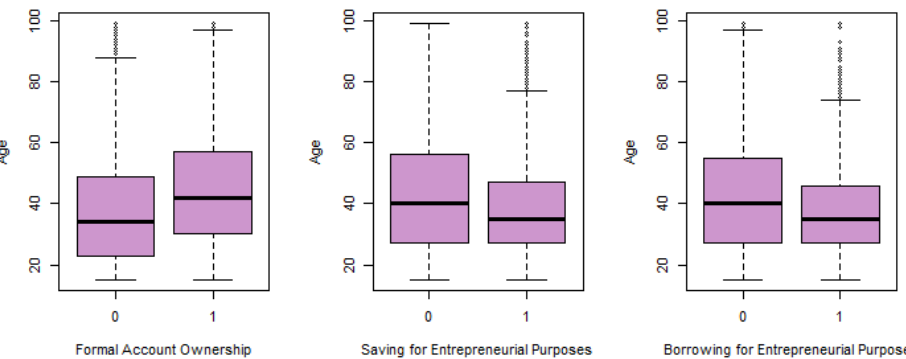
Figure 5. Boxplots of age against formal account ownership, saving, and borrowing for en- trepreneurial purposes. From left to right, the above figure compares the average age of individuals with a formal account, to that of those without ( left panel); the average age of the individuals with entre- preneurial savings, against that of those without ( middle panel); the average age of the individuals with entrepreneurial borrowings, against that of those without ( right panel).